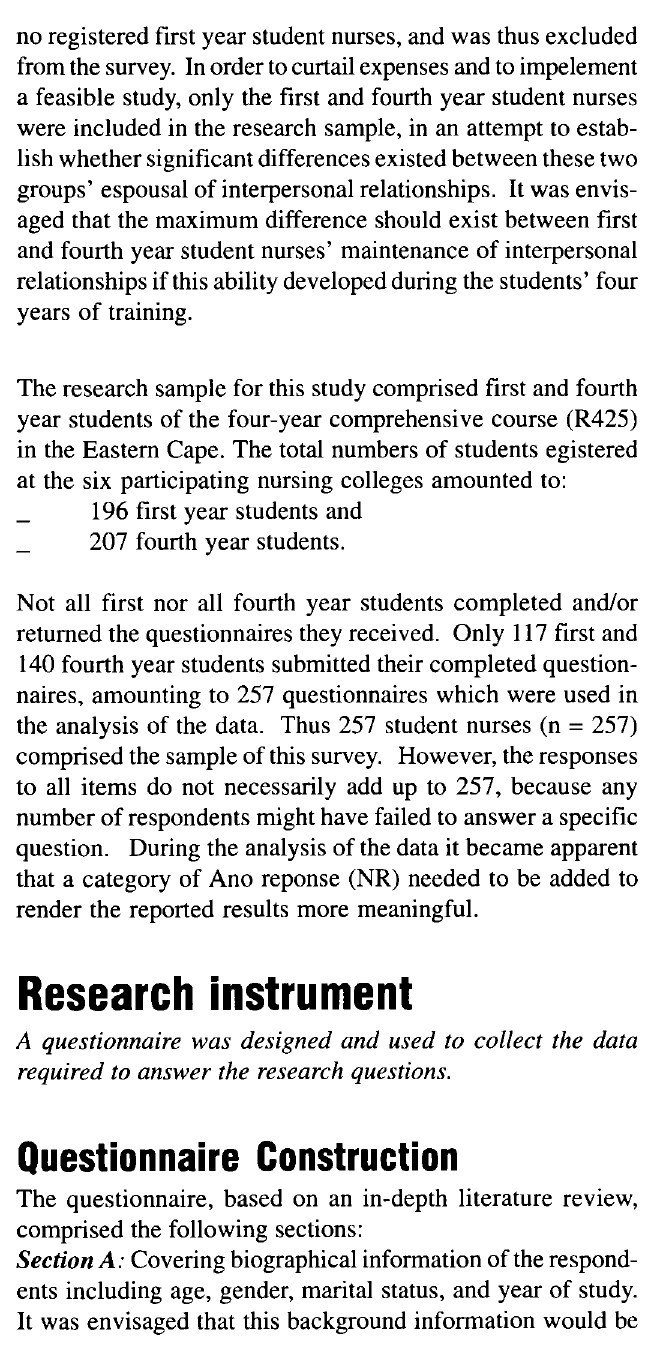
Table 1 : Participating students by region: Eastern Cape R E G IO